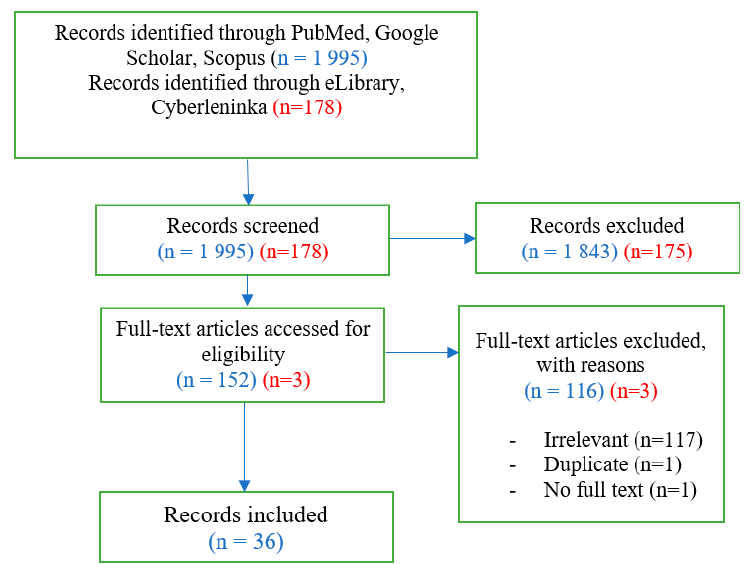
Figure 1. PRISMA flow diagram. The red code indicates the English scientific databases; the blue code indicates the Russian databases .